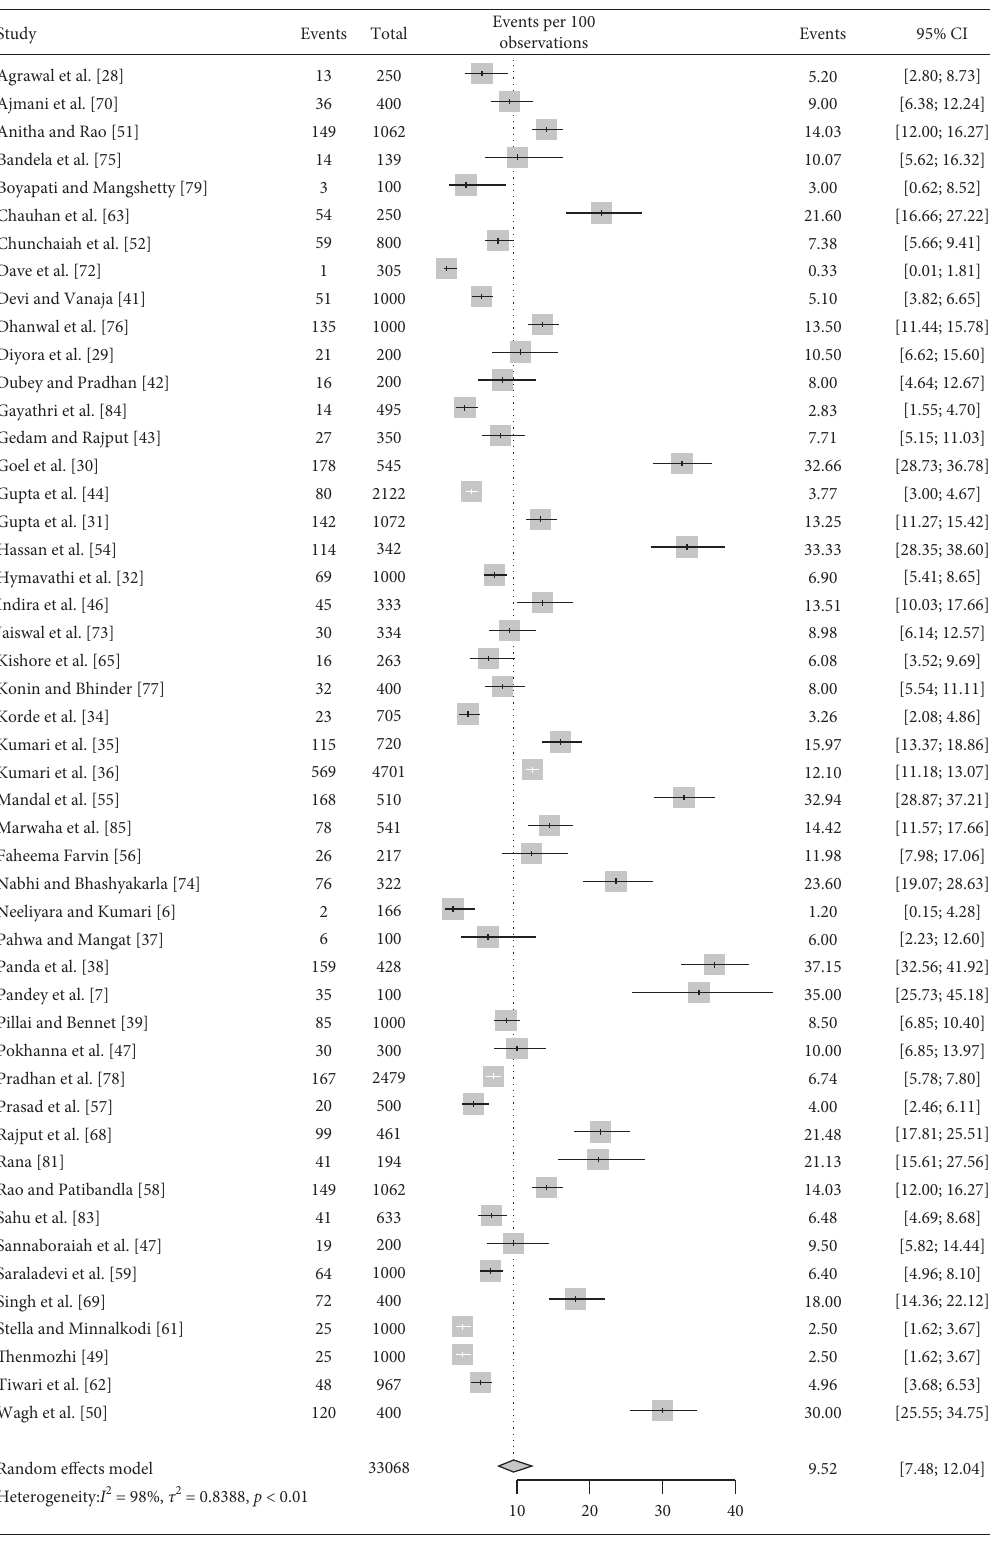
Figure 3: Forest plot showing pooled estimate for prevalence of subclinical